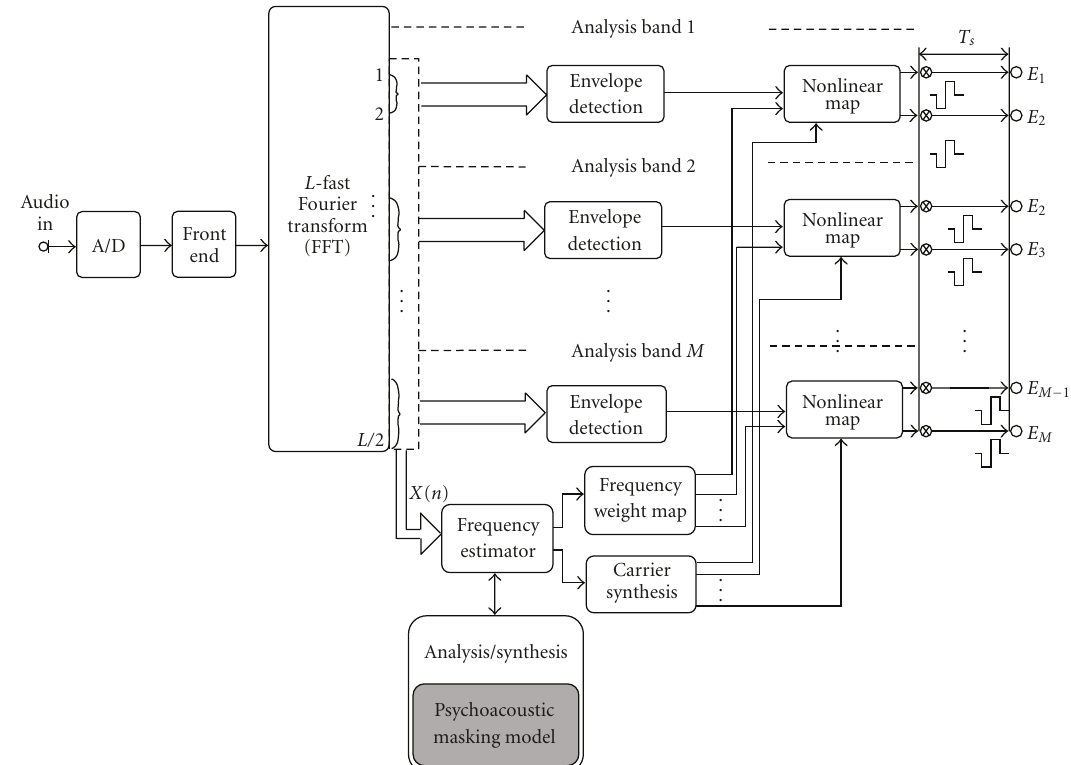
Figure 4: Block diagram illustrating